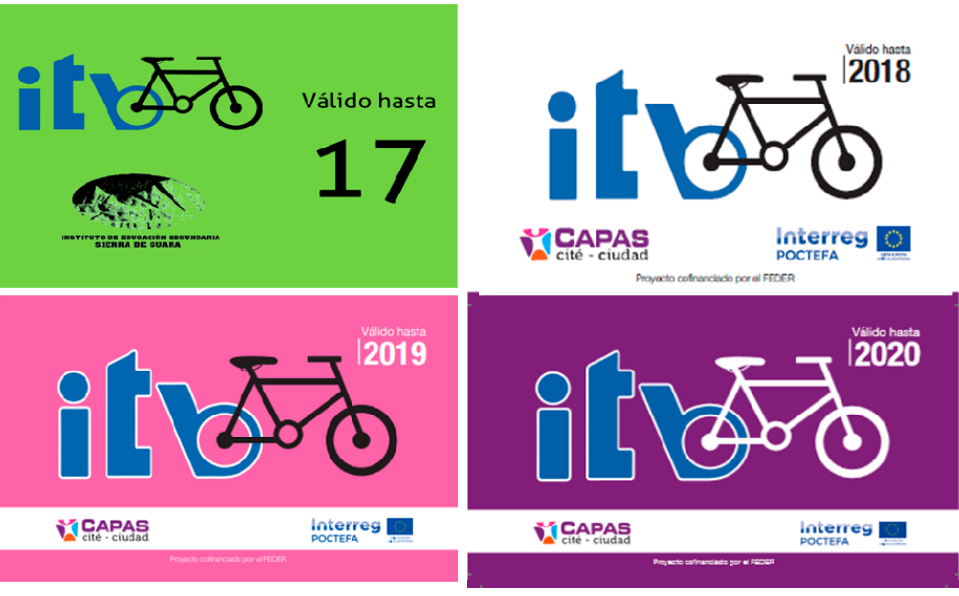
Figure 3. ITB certificates for 2016, 2017, 2018, and 2019.